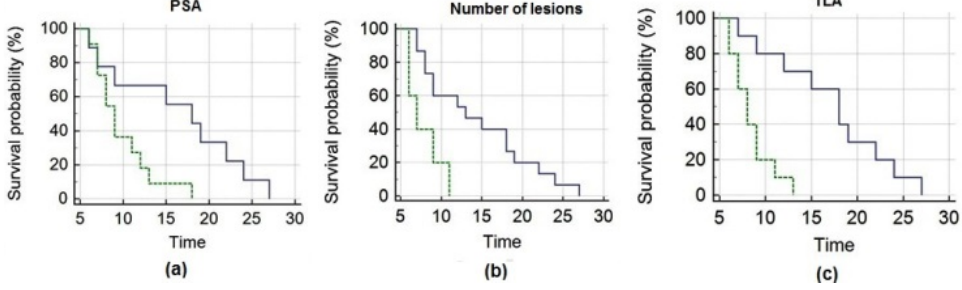
Figure 2. Kaplan–Meier analysis depicts overall survival after 223 Ra-therapy as a function of pre-treatment PSA ( a ), number of lesions ( b ) and TLA ( c ), respectively. Panel ( a ) shows that patients with PSA ≤ 50.2 ng/mL (blue line) had significantly longer survival than those with PSA > 50.2 ng/mL (green line). Panel ( b ) depicts that subjects with a number of lesions ≤ 20 (blue line) presented significantly longer survival than those presenting > 20 lesions (green line). Panel ( c ) demonstrates that subjects with TLA ≤ 351.5 g (blue line) survived significantly longer than those with TLA > 351.5 g (green line). Table 3. Results of Kaplan–Meier analysis of clinical and PET-derived parameters.